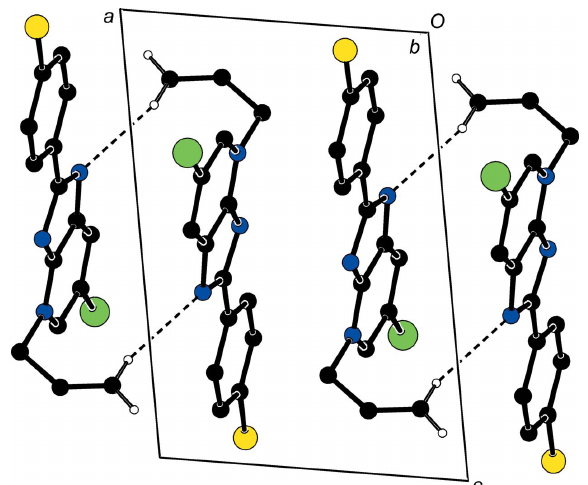
Figure 2 A part of the packing diagram of the title compound, viewed down [010]. The weak intermolecular C—H (cid:3)(cid:3)(cid:3) N hydrogen bonds are shown as dashed lines. H atoms not involved in the hydrogen bonding have been omitted for clarity.